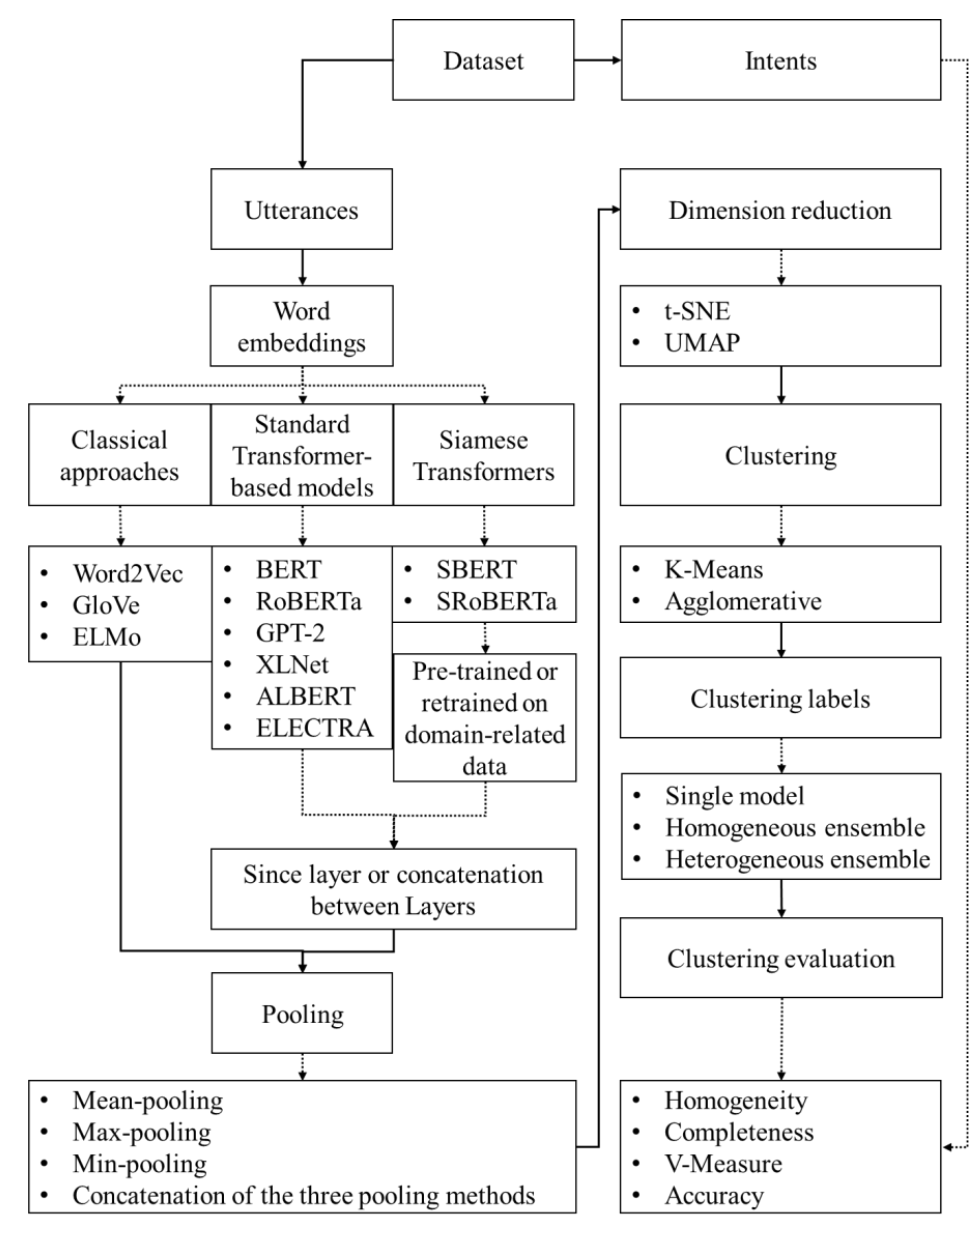
Figure 1. Followed evaluation procedure.